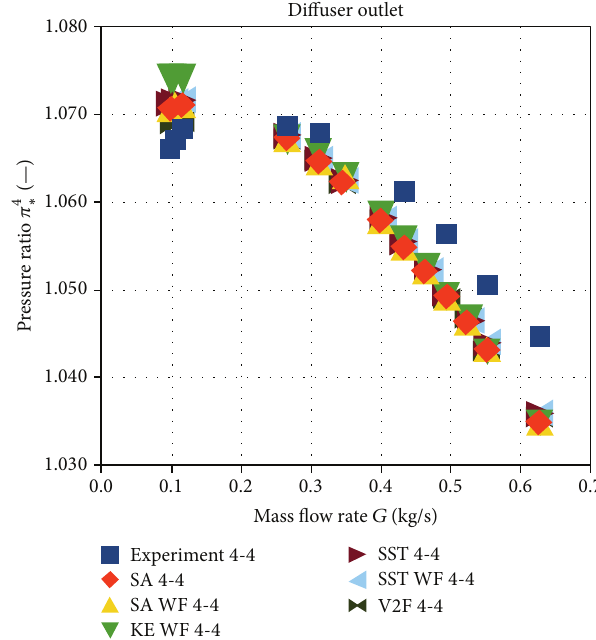
Figure 5: Pressure characteristic at the diffuser inlet for different turbulence models using first-order upwind discretization.